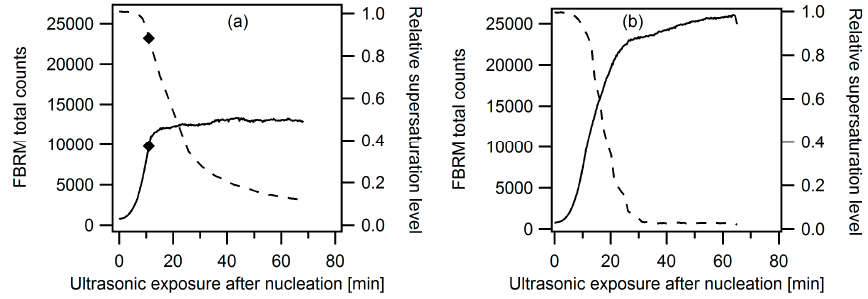
Figure 13. Comparison of the FBRM and IR trend of an experiment from: zone I ( a ); and zone II ( b ), yielding star-shaped and mono-crystals, respectively. The solid lines represent the FBRM data and the dashed lines show the relative supersaturation level.